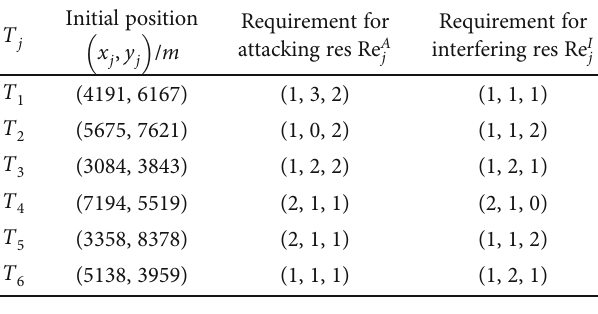
Table 5: The initial state of targets.